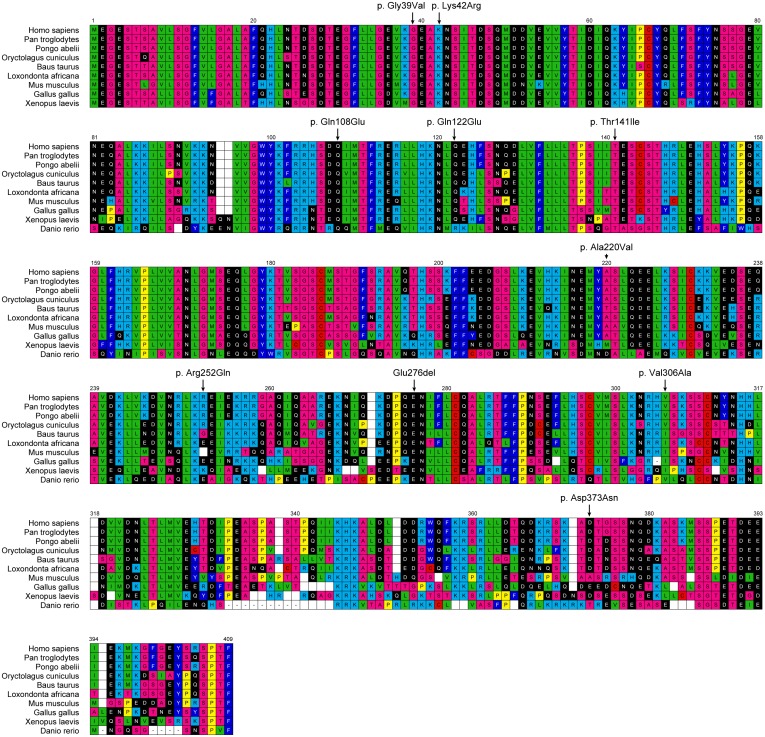
ABRAXAS multiple-sequence alignment.Substitution designations are indicated above the corresponding human reference sequence residue. Amino acid symbols are colored to represent standard Dayhoff groupings.